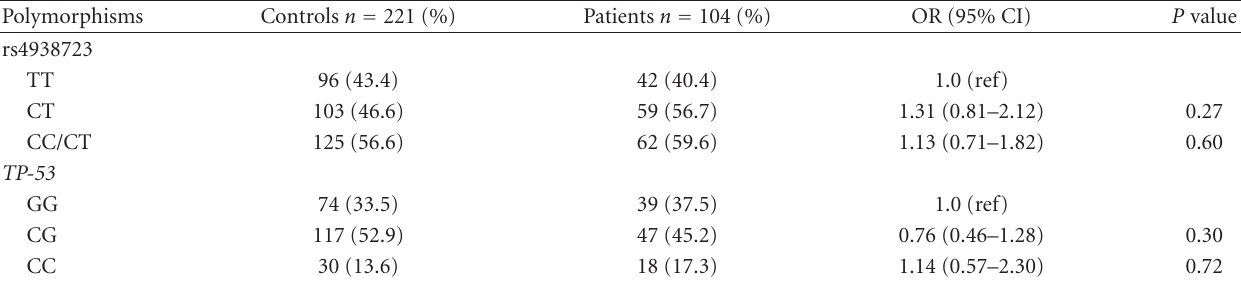
Table 5: Genotype frequencies of miR-34 rs4938723 and TP-53 Arg72Pro in female subjects.